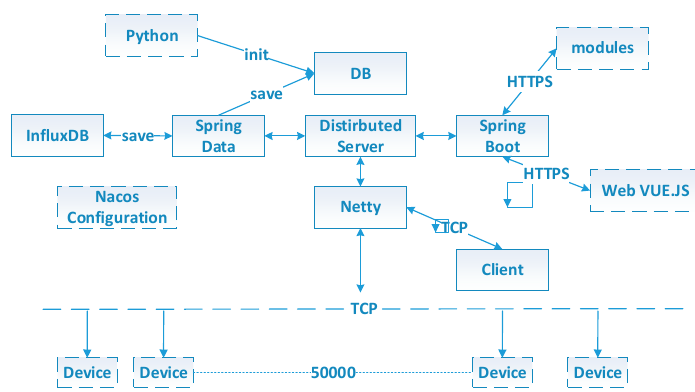
Figure 13. The developed bridge application, used by EMULSION.